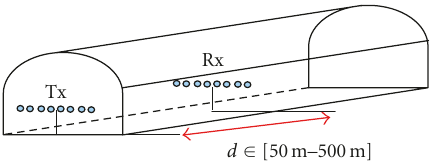
Figure 3: Configuration of the wideband MIMO measurements.